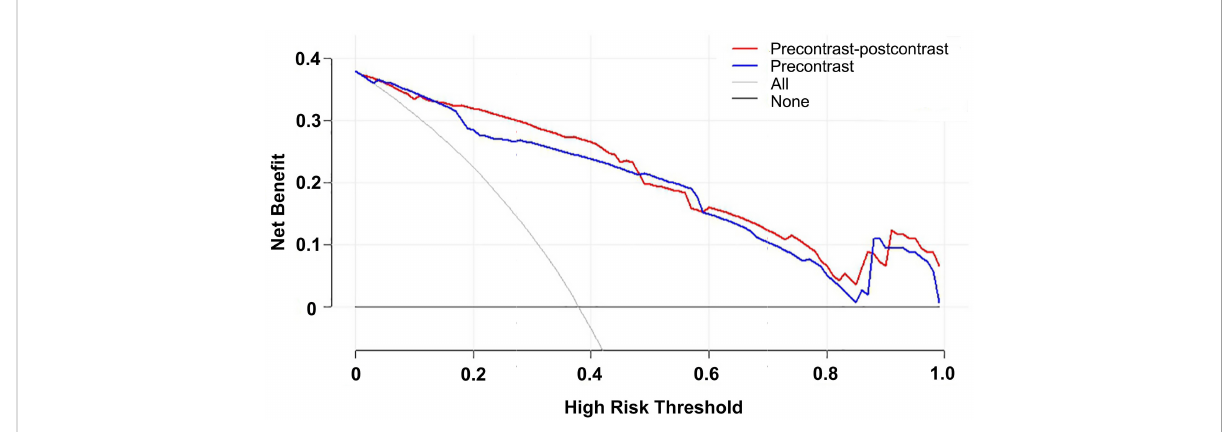
FIGURE 4 Decision curve analysis for the two nomograms. The net bene fi ts of the precontrast – postcontrast nomogram were slightly superior to the bene fi ts of the precontrast nomogram across most ranges of threshold probability. Red line, precontrast – postcontrast nomogram; blue line, precontrast nomogram; gray line, all patients were high grade; black line, all patients were low